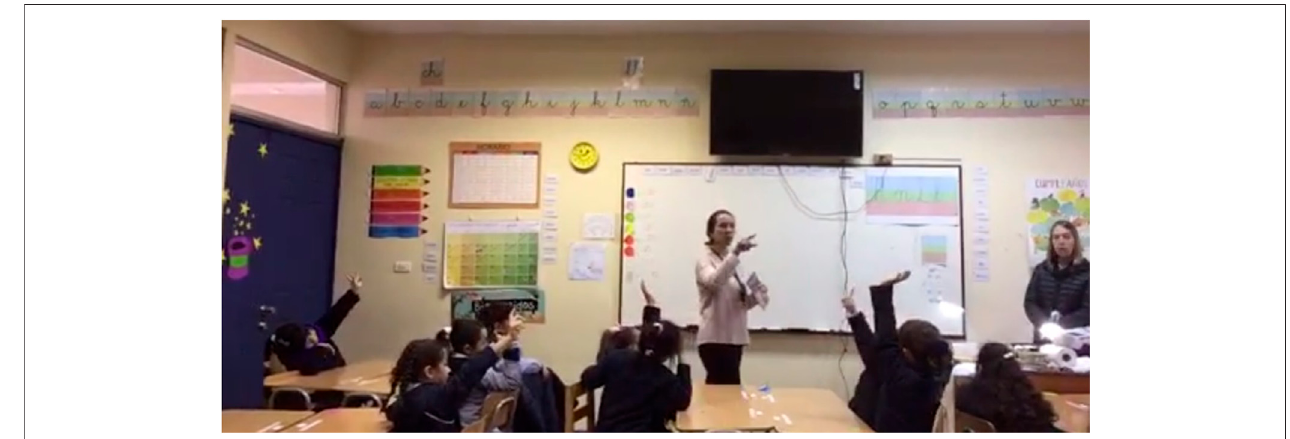
FIGURE 1 | Typical frame of a video obtained with a smartphone placed at the back of the classroom.